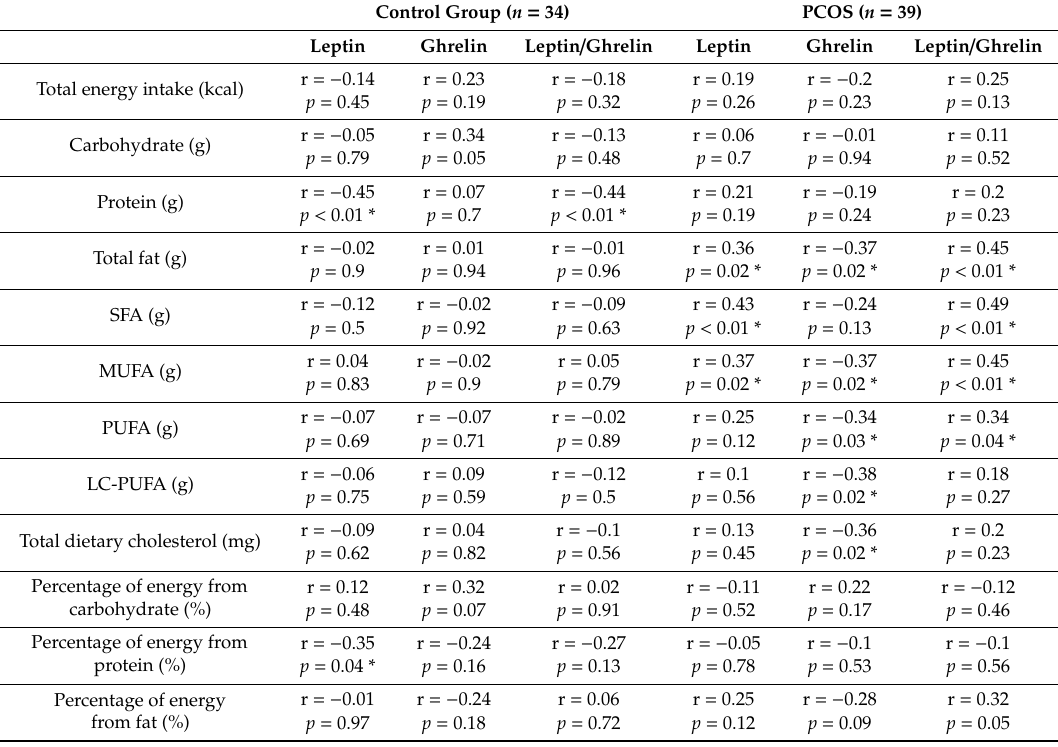
Table 3. Correlations of leptin and ghrelin concentrations and the leptin / ghrelin ratio with the dietary intake of